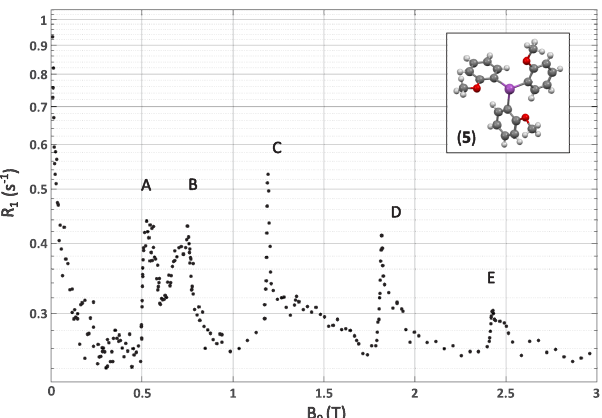
FIG. 8. Proton T 1 -NMRD profile of the solid powder-sample (5) at 298 K obtained by a STELAR (Mede, Italy) Spinmaster relaxometer equipped with a magnet operating up to 3 T. Features A – E of the proton R 1 relaxation dispersion can be attributed unambiguously to QRE peaks superimposed on a background due to proton-proton dipolar